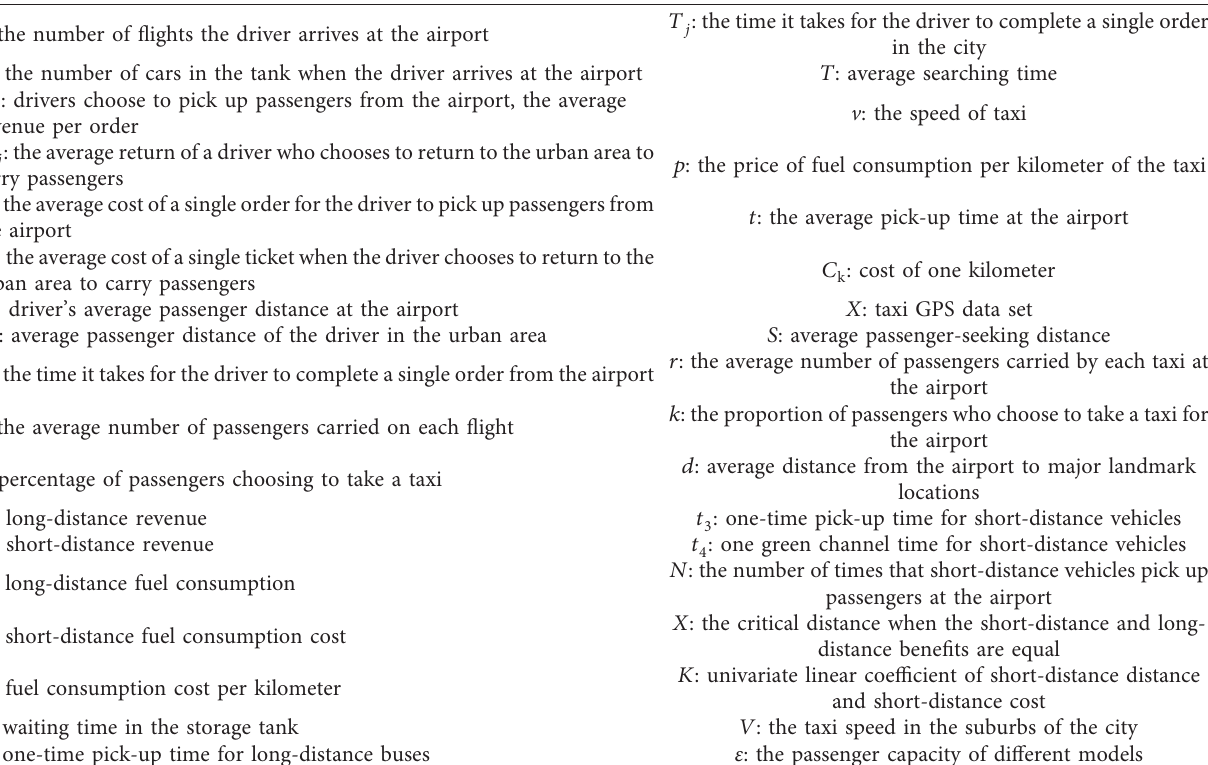
Table 1: Modeling symbols and